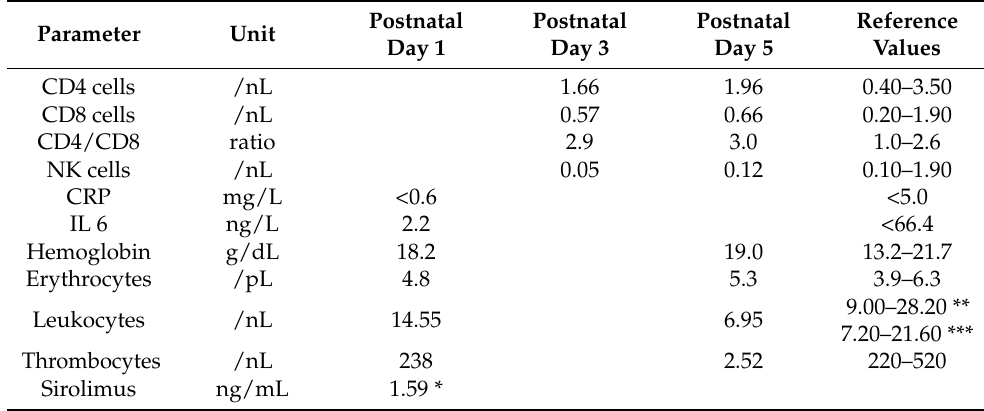
Table 2. Selected laboratory values of the newborn. * from cord blood, 8 days after terminating sirolimus treatment; ** at postnatal day 1; *** at postnatal day 5. Parameter Unit